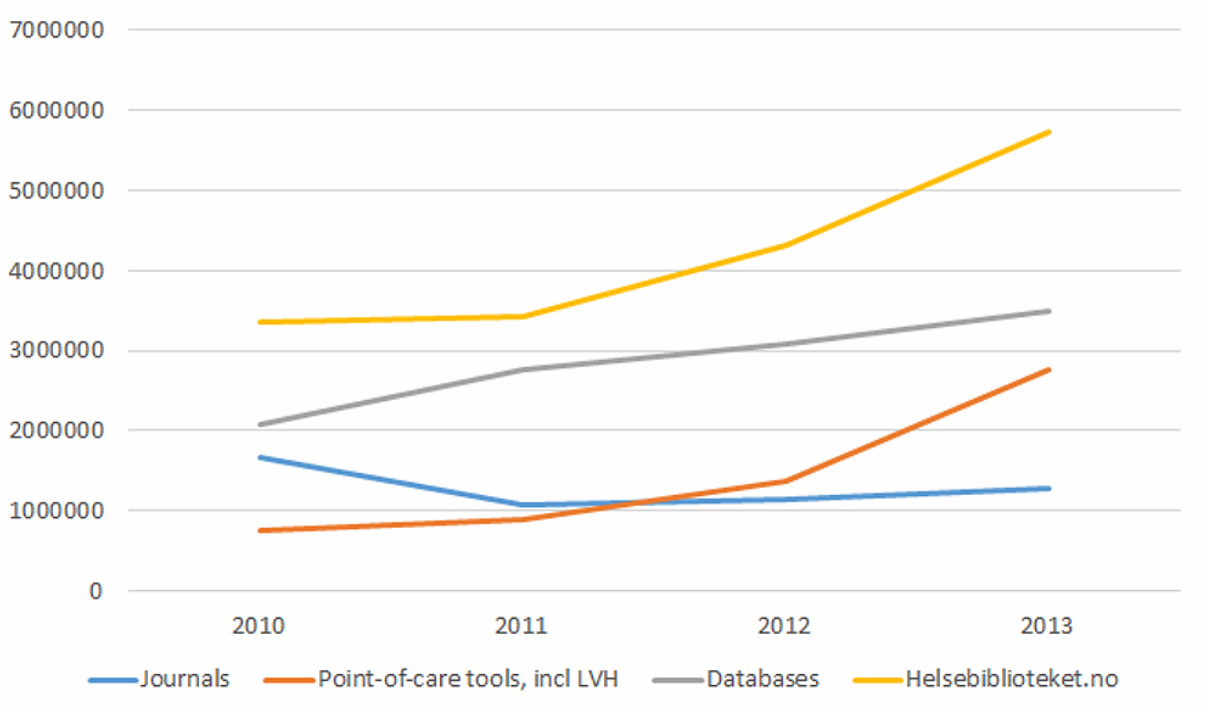
Figure 2. Pageviews of The Library website (Helsebiblioteket.no) versus purchased